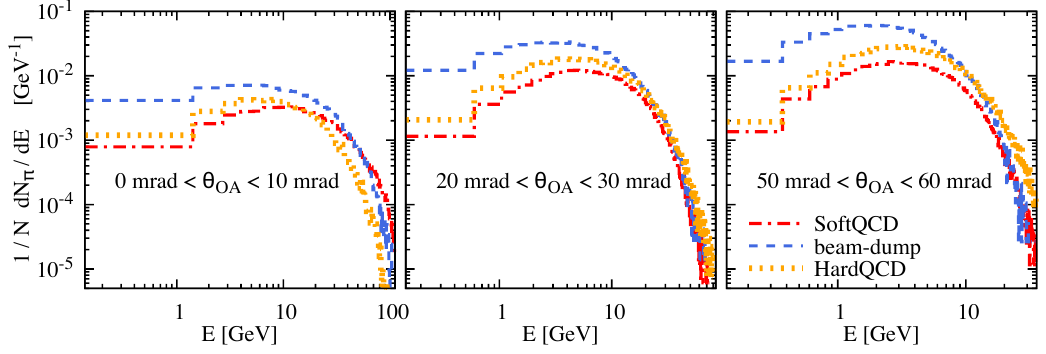
Figure 13 . Energy spectrum of π 0 s produced in the beam dump in three angular windows: 0 < θ 10 mrad (left panel), 20 mrad < θ 30 mrad (middle panel) and 50 mrad < θ OA < OA < OA < 60 mrad (right panel). The three curves correspond to the three meson samples introduced in the main text: primary-only (SoftQCD) in red dot-dashed, beam-dump in blue dashed primary-only (HardQCD) in orange